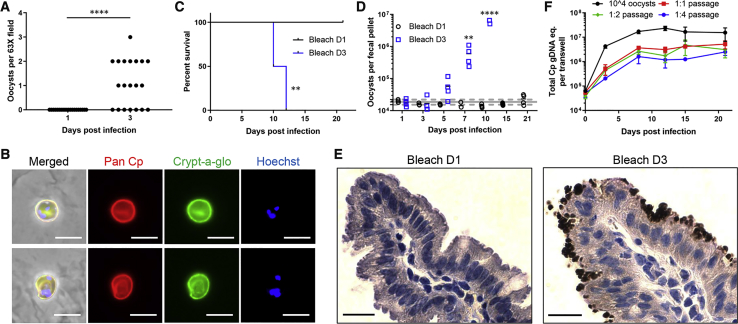
Infectivity of oocysts produced in ALI cultures(A) Detection of oocysts in ALI cultures treated with bleach. ALI transwell cultures were infected with 1 μm-filtered sporozoites. On days 1 and 3 postinfection, transwells were bleached, washed, pelleted, adhered to PLL-coated coverslips, and stained with Pan Cp followed by goat anti-rabbit Alexa Fluor 568 and Crypt-a-glo directly conjugated to FITC. Each data point is the number of oocysts in a single 63X field from a single representative experiment. Data were analyzed using a Mann-Whitney U test. ∗∗∗∗ p < 0.0001. See also Figure S6 for replicate experiment.(B) Images of bleached oocysts isolated from ALI cultures at day 3 postinfection as described in (A). Oocysts were stained with Pan Cp followed by goat anti-rabbit IgG Alexa Fluor 568, Crypt-a-glo directly conjugated to FITC, and Hoechst. Scale bars, 5 μm.(C and D) Infectivity of bleached ALI monolayers for mice. ALI transwell cultures were infected with 1 μm-filtered sporozoites. On days 1 and 3 postinfection, transwells were bleached, washed, and the material was orally gavaged into naïve Ifngr1−/− mice.(C) Survival curves of the mice analyzed using the log-rank (Mantel-Cox) test, ∗∗p < 0.01.(D) Number of oocysts per fecal pellet as measured by qPCR for the C. parvum GAPDH gene. The gray line represents the mean value of both groups for day 1; the dotted lines are the day 1 standard deviations. Data was analyzed using a two-way ANOVA comparing the means of Bleach D1 vs Bleach D3 across all time points, corrected for multiple comparisons using the Sidak method, ∗∗ p < 0.01, ∗∗∗∗ p < 0.0001. See also Figures S6B and S6C for replicate example.(E) Histological examination of mice infected with bleached material from ALI cultures. Sections of small intestine stained with Pan Cp and revealed by IHC. Day 1 recipient was sacrificed on day 30 postgavage (image on left), day 3 recipient was sacrificed on day 9 postgavage (image on right). Scale bars, 20 μm.(F) Passage of bleached ALI monolayers. ALI transwell cultures were infected with 1 μm-filtered sporozoites. Bleached day 3 ALI cultures were used to infect naïve ALI monolayers at a 1:1, 1:2 or 1:4 passage ratio. In parallel, ALI cultures were infected with 104 calf-derived oocysts. Outgrowth of passaged C. parvum was monitored by qPCR. Data plotted as mean ± S.D. from two transwells per time point. See Figure S6D for replicate experiment.